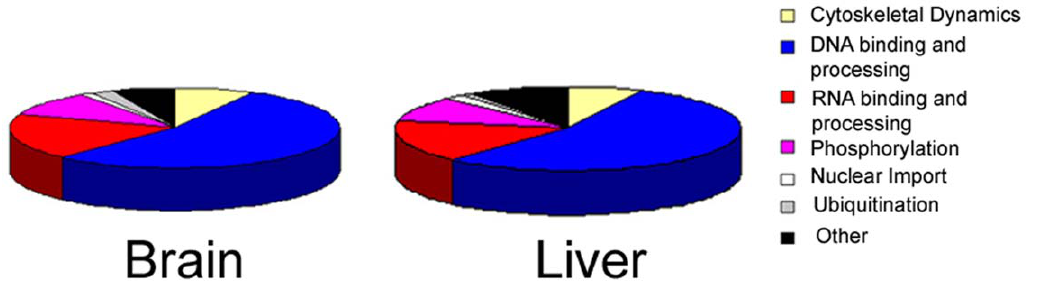
Figure 5. The nuclear proteome. The molecular functions annotated by GO of the quantified nuclear phosphoproteins from liver and brain.